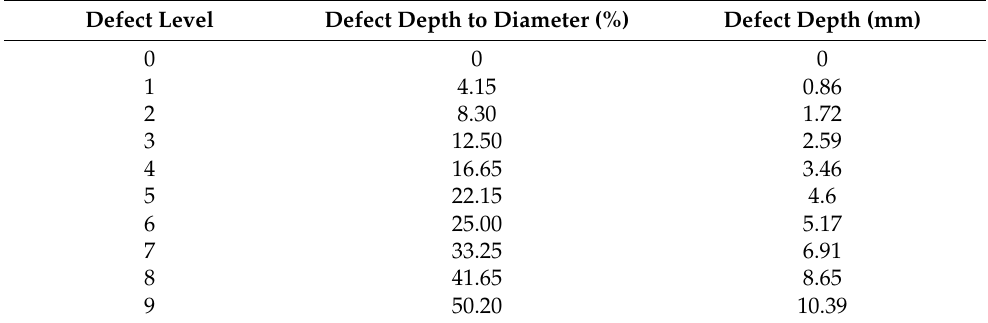
Table 1. Defect level of the axle (crack depth).